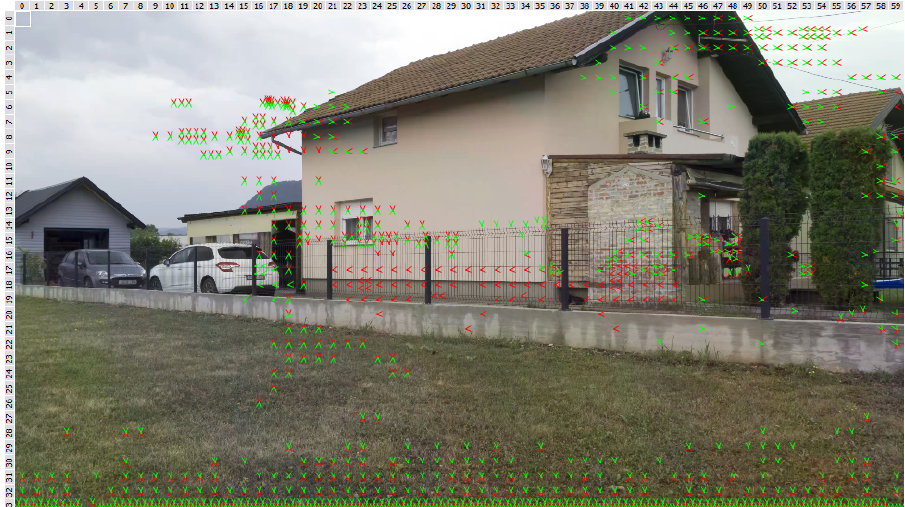
Figure 5. Motion vectors—low temporal complexity